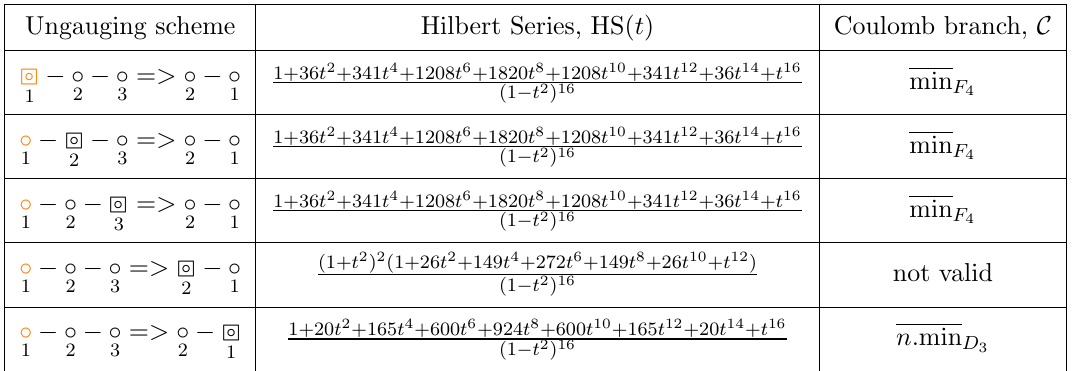
Table 4 . Di(cid:11)erent ungauging schemes for the a(cid:14)ne F 4